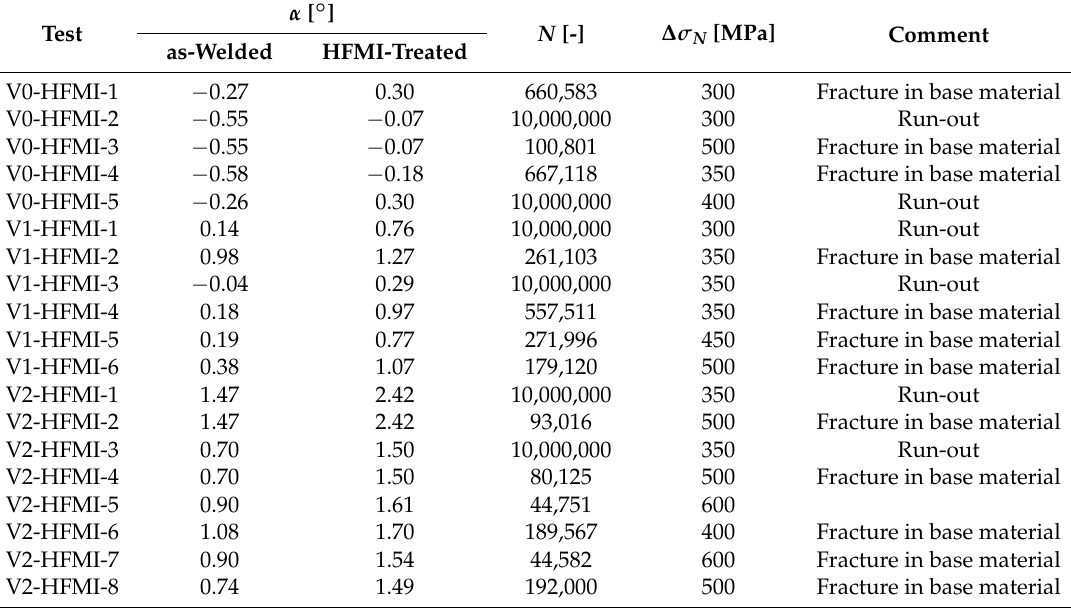
Table A2. Fatigue test data of HFMI-treated